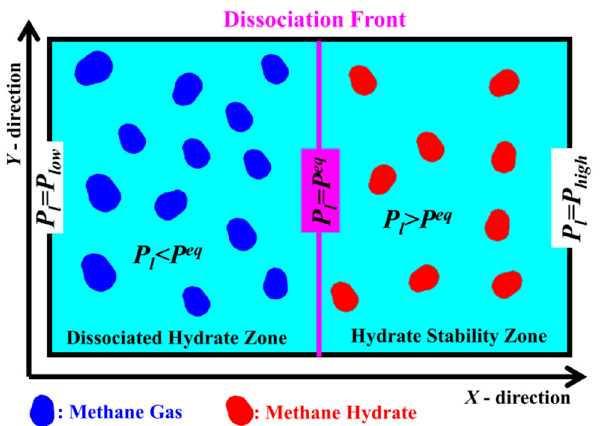
Figure 1. Schematic of a 2D porous medium domain that is shown as an effective porous medium. The turquoise color depicts the combination of the solid matrix and the liquid-occupied pore space. Gas-occupied and hydrate-occupied pore spaces are denoted with blue and red colors, respectively. The characteristic pressure zones are also indicated. The magenta line indicates pressure conditions, where P l = P eq